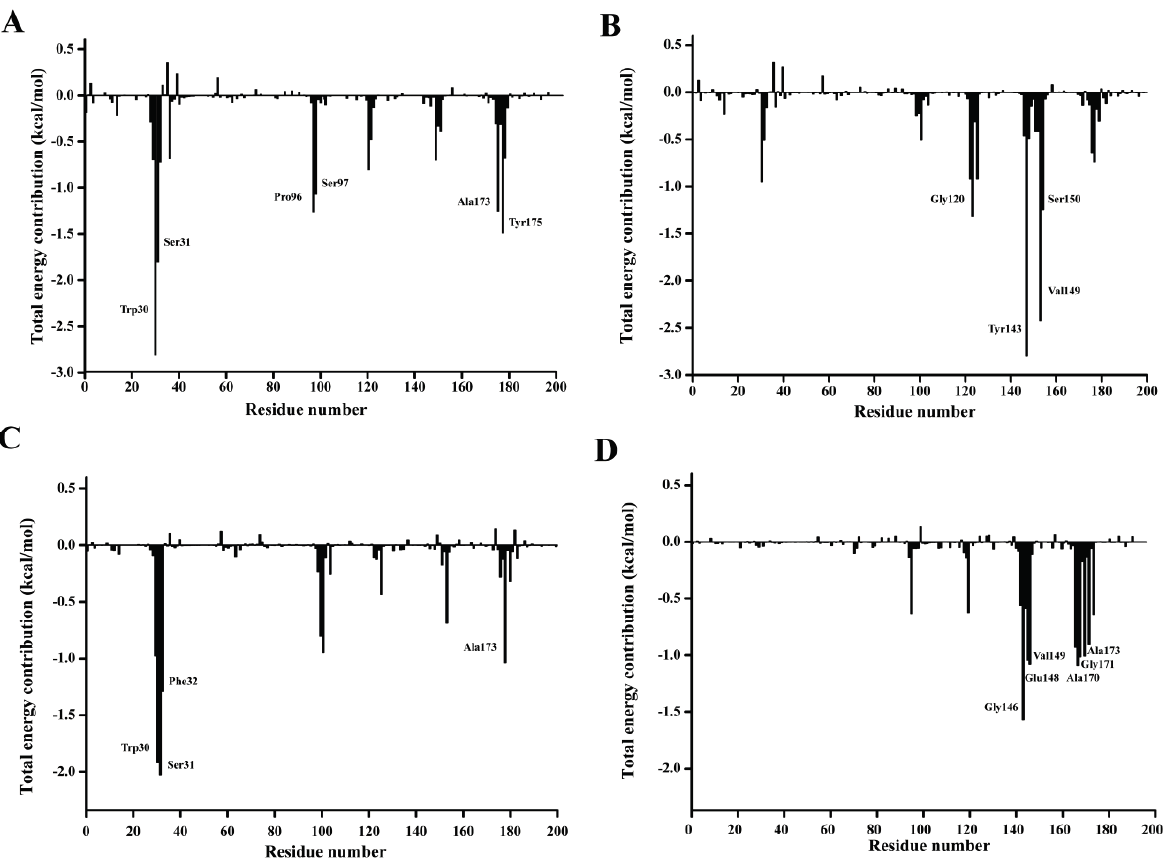
Figure 12. Residue-residue interaction spectra for all kinds of complexes according to the MM-PBSA method. The x-axis denotes the residue number, and the y-axis denotes the interaction energy between the P186_1588 and each residue. The important residues (< − 1 kcal·mol − 1 ) for binding are marked by corresponding texts. ( A ) The residue-residue interaction spectra for the complex of P186_1588 and p -NPC2; ( B ) The residue-residue interaction spectra for the complex of P186_1588 and p -NPC4; ( C ) The residue-residue interaction spectra for the complex of P186_1588 and p -NPC8; ( D ) The residue-residue interaction spectra for the complex of P186_1588 and p -NPC10.